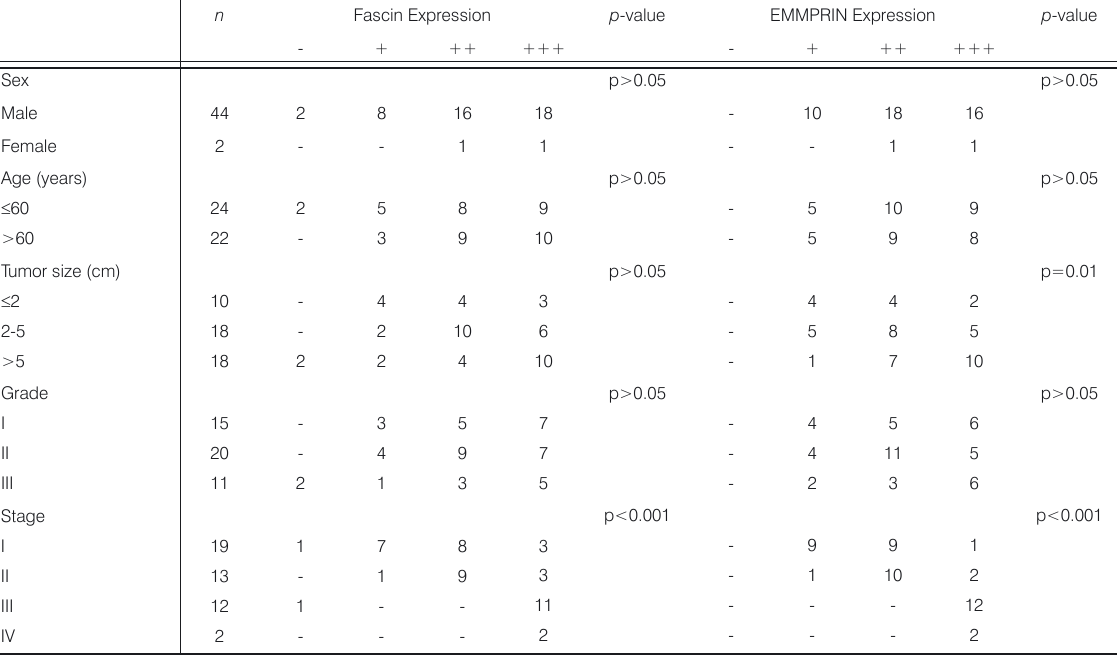
Table 1. Fascin and EMMPRIN expression levels and relationships with clinicopathological features in